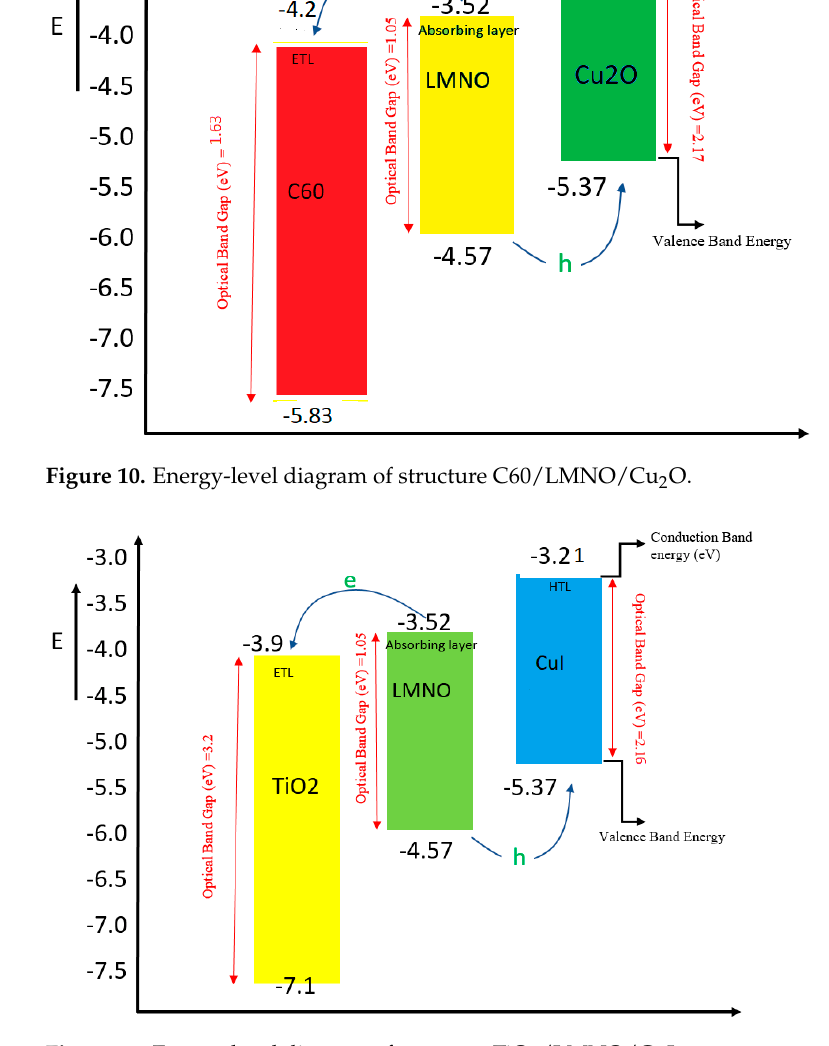
Figure 11. Energy-level diagram of structure TiO 2 /LMNO/CuI.